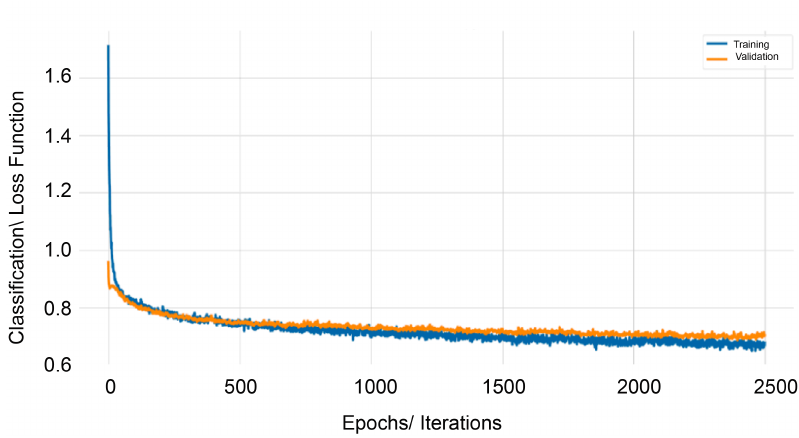
Figure 13. δ 2 Categorical cross-entropy vs. the number of